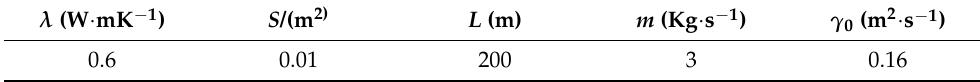
Table 1. Heat pipeline parameters [4,25].